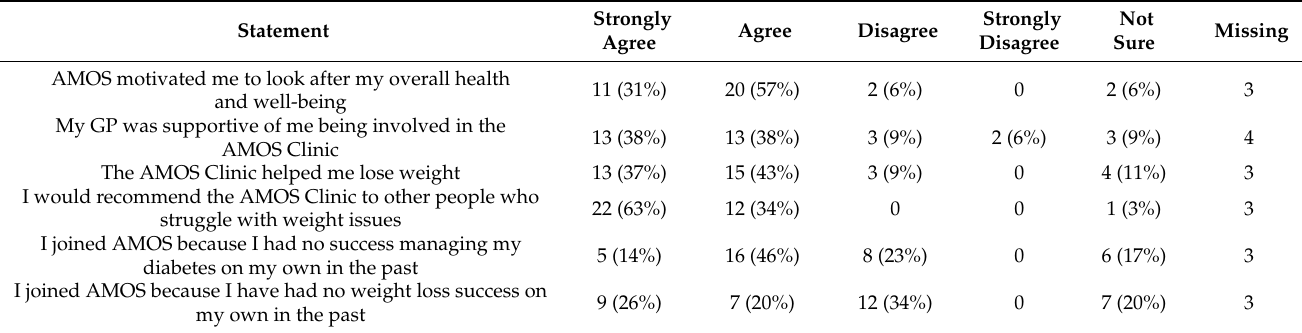
Table 4. Patient survey results—Theme 4: exploring